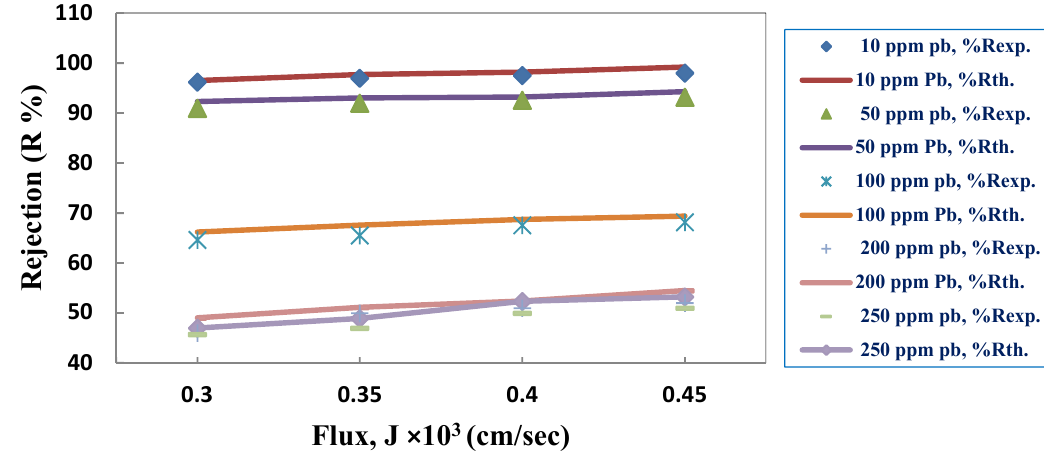
Figure 11. Results of CFSD model for the dataset of the PES3 membrane for Pb(NO 3 ) 2.